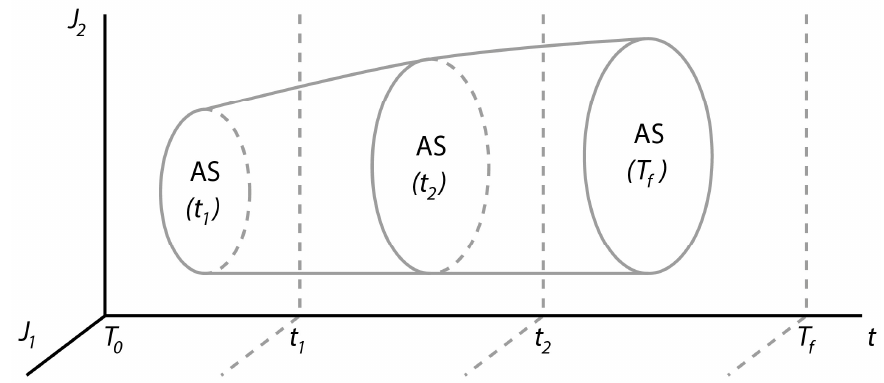
Figure 4. Representation of dynamic changes in schedule performance by attainable sets. Algorithms 2018 , 11 , x FOR PEER REVIEW 15 of 20